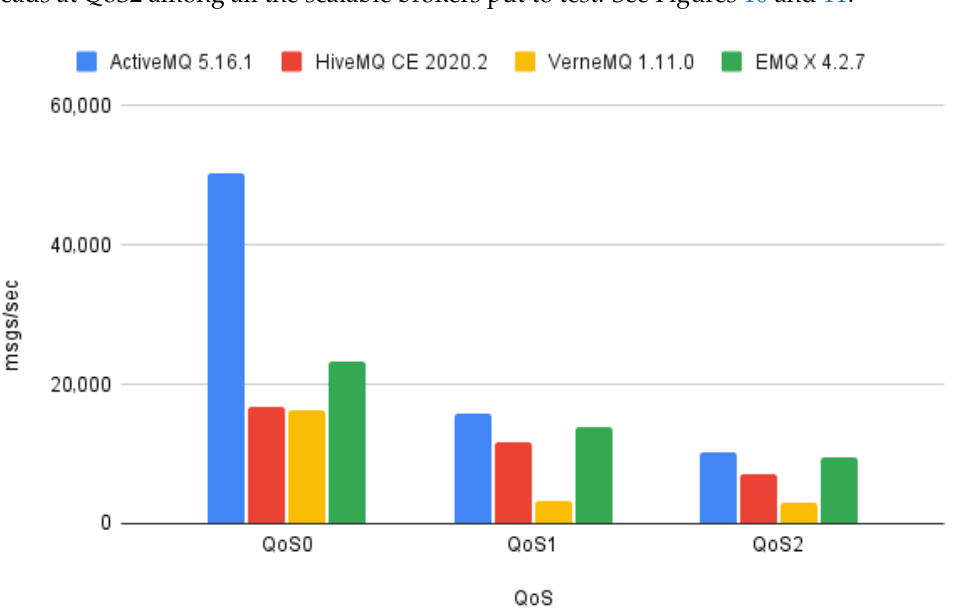
Figure 11. Projected message rate (msgs/sec) of scalable brokers at ˜100% system CPU usage in cloud evaluation